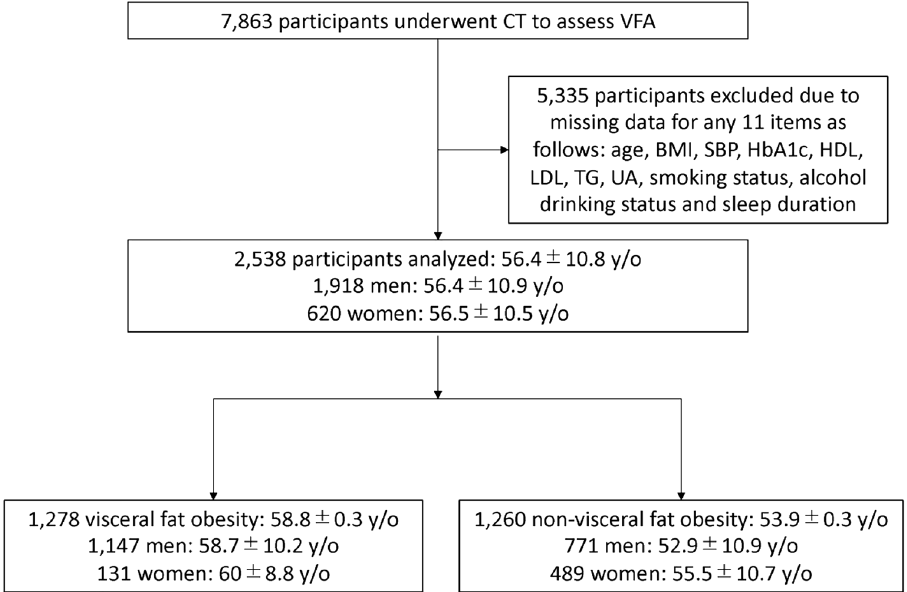
Figure 1. Study recruitment flowchart. Of 7863 participants who underwent computed tomography (CT) to assess the visceral fat area (VFA), 2538 participants with no missing data for age, body mass index (BMI), systolic blood pressure (SBP), glycated hemoglobin (HbA1c), high-density lipoprotein (HDL) and low-density lipoprotein (LDL) levels, triglyceride (TG) levels, uric acid (UA), smoking status, alcohol consumption status, and sleep duration were analyzed. Age is expressed as mean ± standard